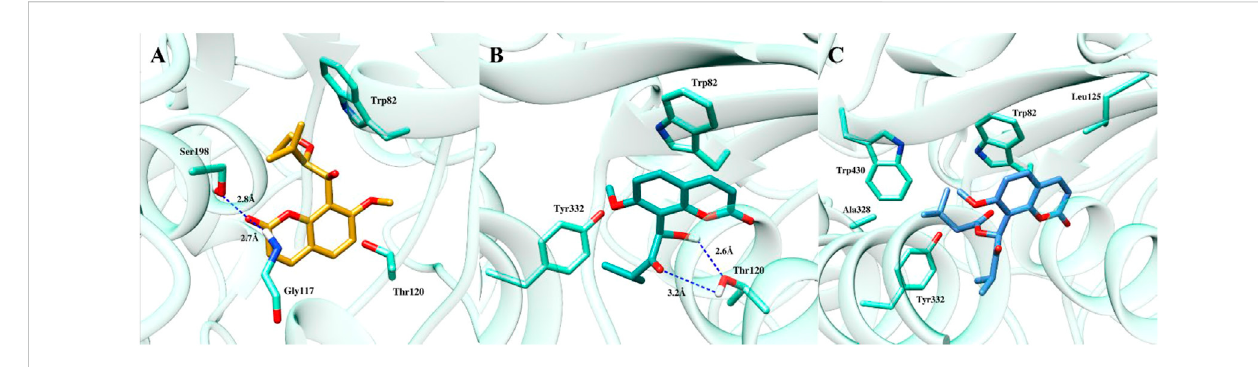
FIGURE 4 Docked pose of all the coumarin derivatives with BChE. (A) 2 ′ - O -ethylmurrangatin ( 1 ), (B) murranganone ( 2 ) and (C) paniculatin ( 3 ) resided in the active site of BChE.